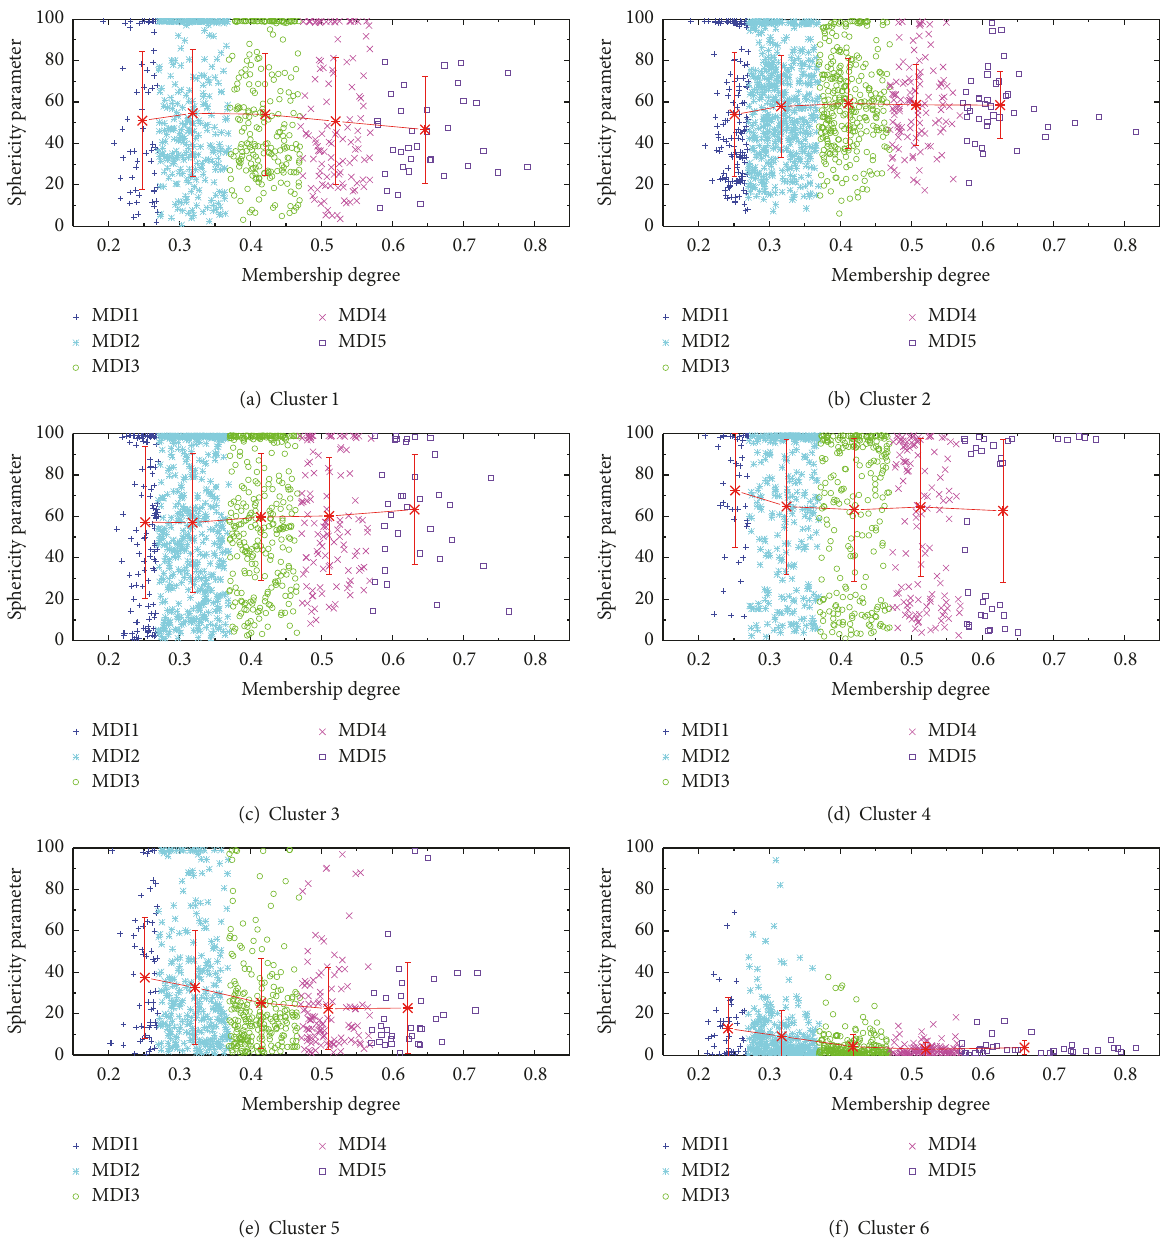
Figure 13: Scatterplots between sphericity parameter and membership